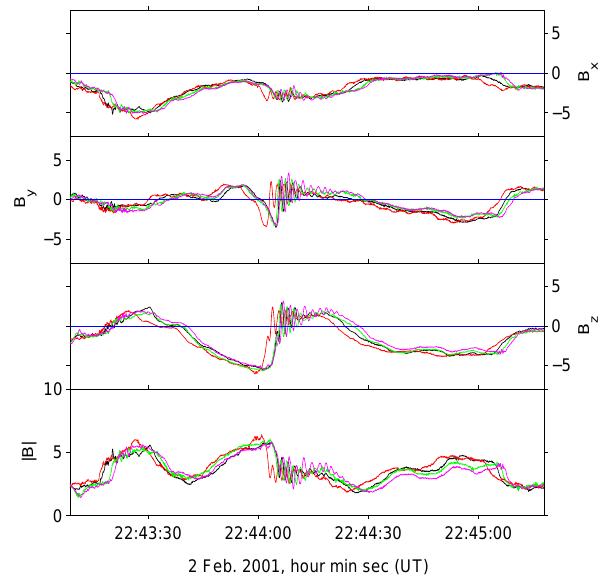
Fig. 12. Magnetic field data at 22 vectors/s in GSE coordinates, in the same format at Fig. 5. The data show a shocklet at 22:44UT, with an upstream whistler